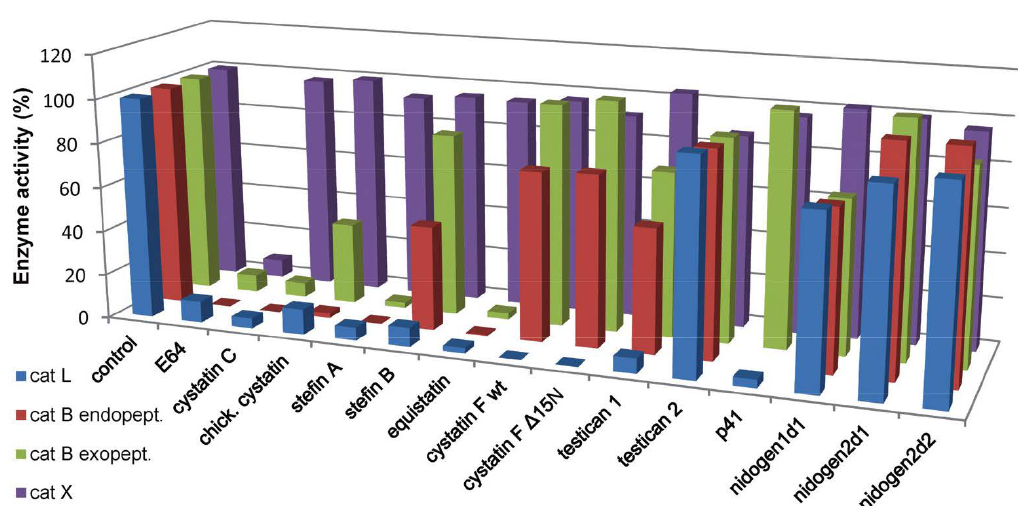
Figure 2: Comparison of the activities of endogenous inhibitors towards cathepsins X, B (exo- and endopeptidase activity) and L. The relative inhibitiory activities of cysteine cathepsins with various inhibitors was tested in a kinetic assay (p41 was not tested on cathepsin B endo- peptidase activity). Concentrations of inhibitors were 100-fold higher than those of the enzymes, E-64, used as a positive control, was tested at 10 µM concentration. Assay buffers were used in control experiments. Values are the means of two or three independent experiments, each performed in